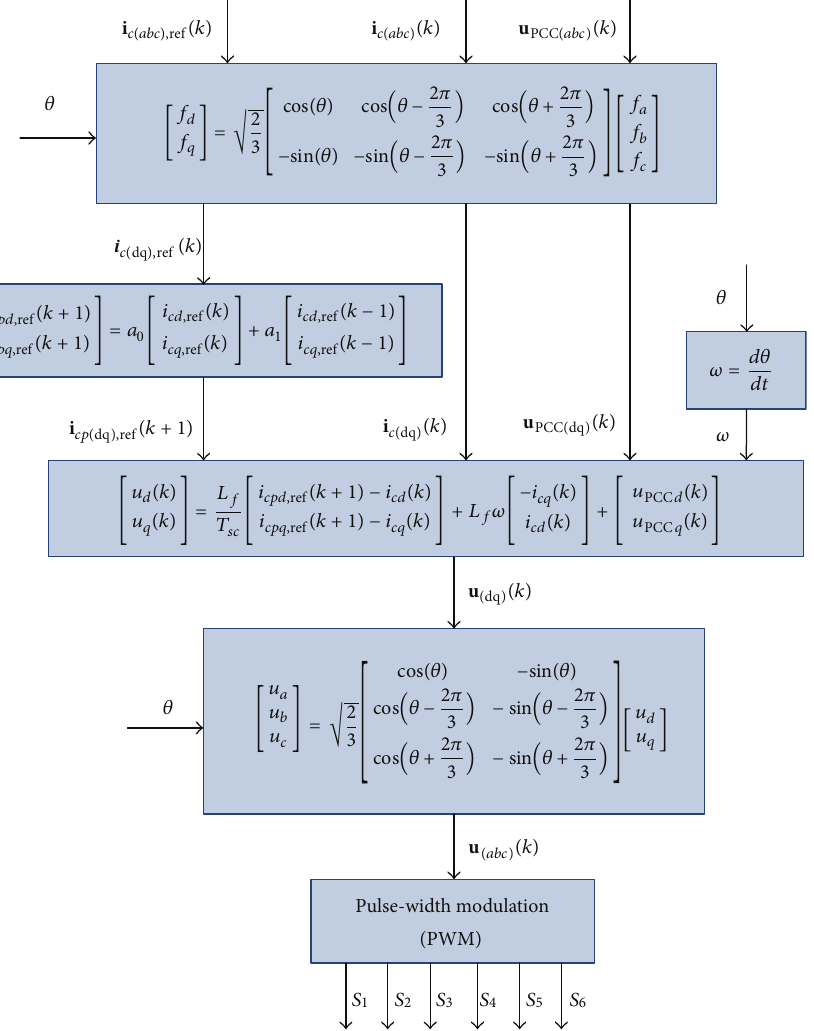
Figure 12: The overall procedure of the predictive current control for